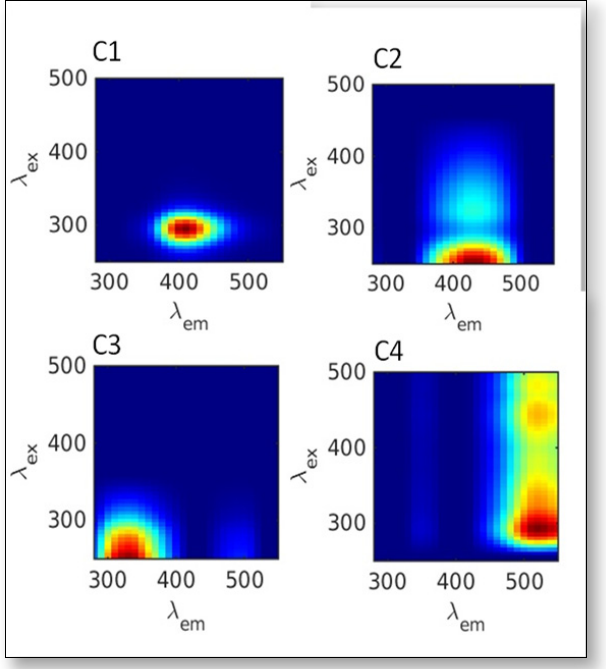
Figure 2. C1-type M peak, two terrestrial-like components (C2 fulvic-like and C4 humic-like) and C3 Figure 2. C1 ‐ type M peak, two terrestrial ‐ like components (C2 fulvic ‐ like and C4 humic ‐ like) and protein-like 2017. C3 protein ‐ like 2017.